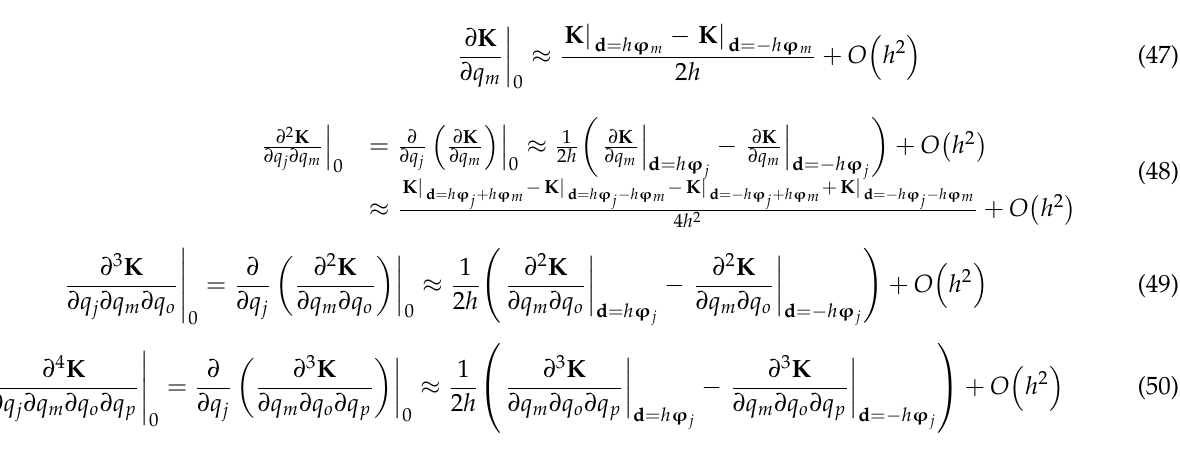
the nonlinear stiffness matrix are given in Appendix A. To increase accuracy order of the